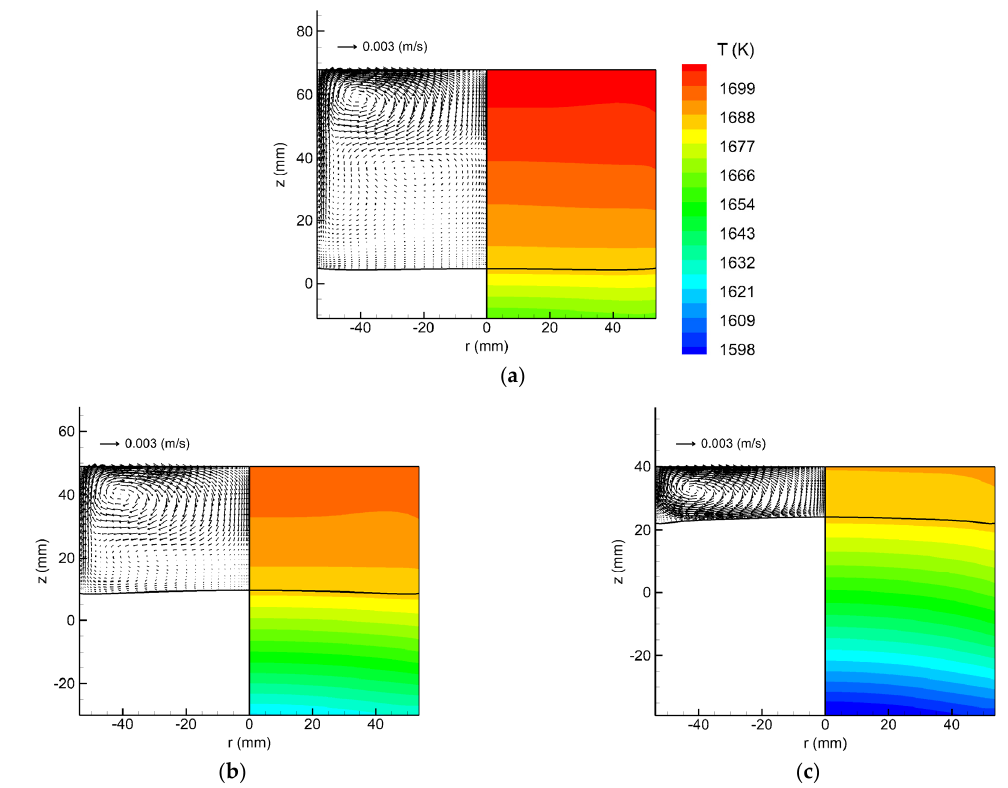
Figure 3. Temperature distribution and flow field in the melt and crystal with a solidified fraction of ( a ) 20%, ( b ) 50% and ( c ) 80%.